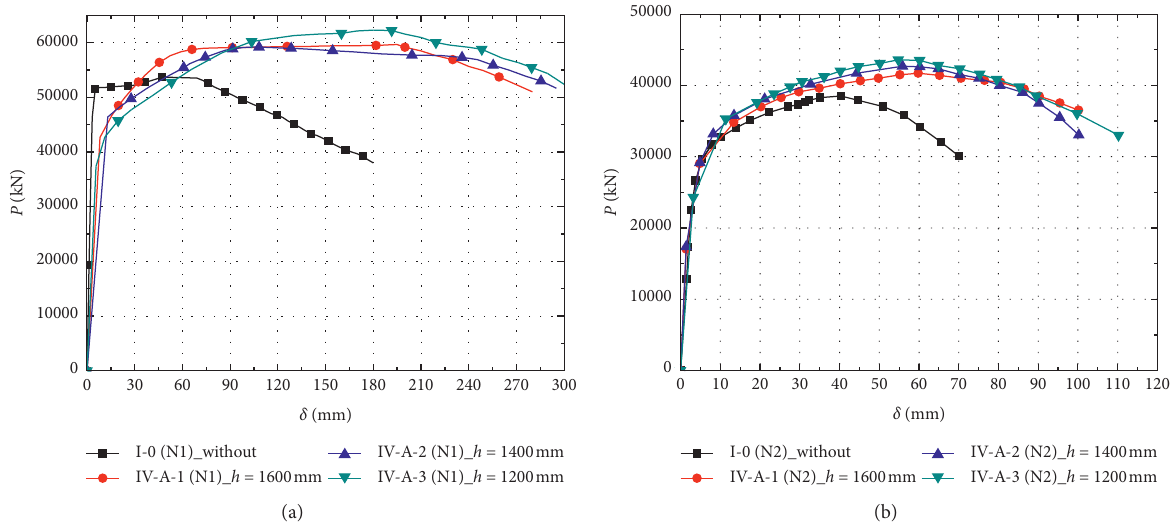
Figure 19: Effects of height of LYP steel tubular plate on skeleton curves. (a) Axially compressed specimens. (b) Eccentrically compressed specimens.